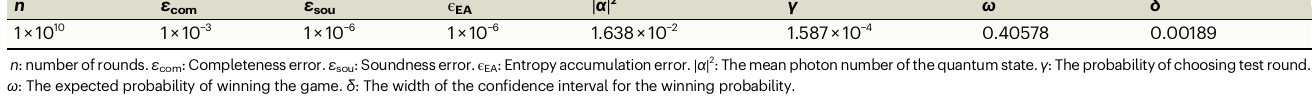
Table 2 | Parameters used in the experiment n n :numberofrounds. ε com :Completenesserror. ε sou :Soundnesserror. ϵ EA :Entropyaccumulationerror. ∣ α ∣ 2 :Themeanphotonnumberofthequantumstate. γ :Theprobabilityofchoosingtestround. ω : The expectedprobability of winningthe game. δ : Thewidth of the con fi dence intervalforthe winning